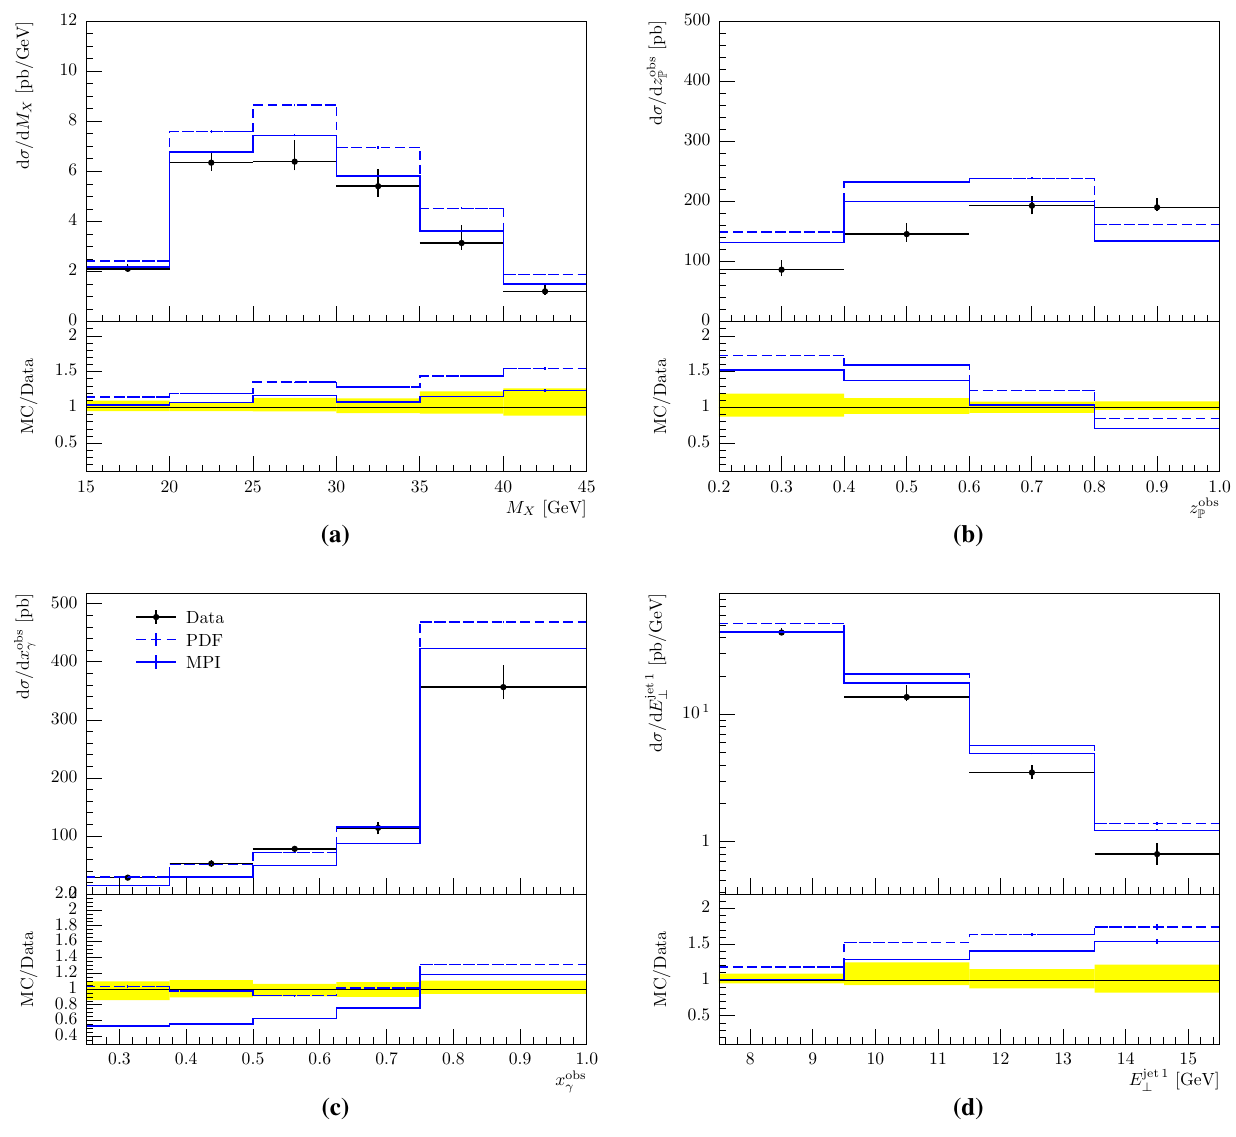
Fig. 6 The model with (solid lines) and without (dashed lines) gap survival compared to ZEUS data on M X ( a ), z obs P ( b ), x obs γ ( c ) and E jet1 ⊥ ( d